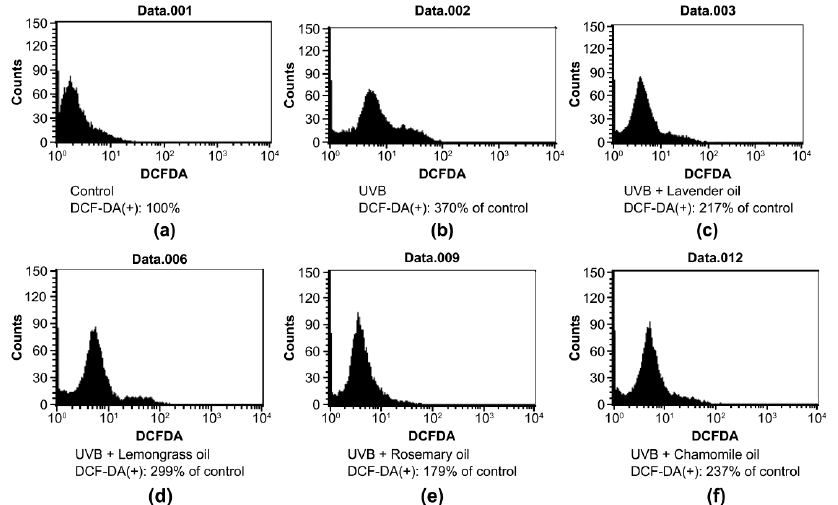
Figure 1. Effect of essential oils on ROS production in UVB-irradiated DPCs. FACS analysis to detect the DCF-DA-positive cells was performed. ( a ) Control DPC. ( b ) UVB-irradiated DPC; and ( c ) Lavender oil-treated, UVB-irradiated DPC. ( d ) Lemongrass oil-treated, UVB-irradiated DPC. ( e ) Rosemary oil-treated, UVB-irradiated DPC. ( f ) Chamomile oil-treated, UVB-irradiated DPC. The average number of DCF-DA-positive cells shown in ( a ) is designated as 100%.